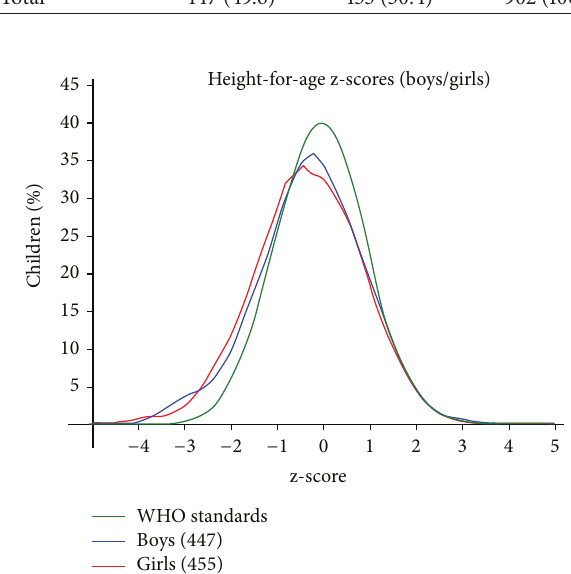
Figure 3: The graph of the normal distribution of height for age in studied children in Salmas (mean ± SD = −0.28 ± 1.08